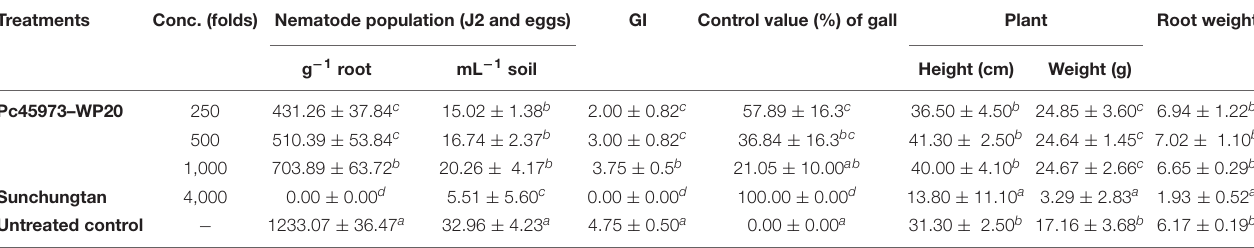
TABLE 8 | Effect of the wettable powder formulation of ethyl acetate layer of Penicillium commune KACC 45973 (Pc45973–WP20) on gall formation, nematode populations in roots and soils, and shoot and root growth of tomato plants infected with Meloidogyne incognita. Treatments Conc. (folds) Nematode population (J2 and eggs) GI